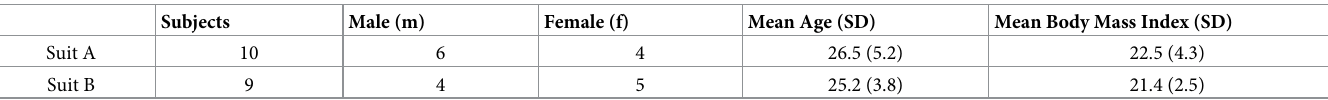
Table 1. Baseline participant´s